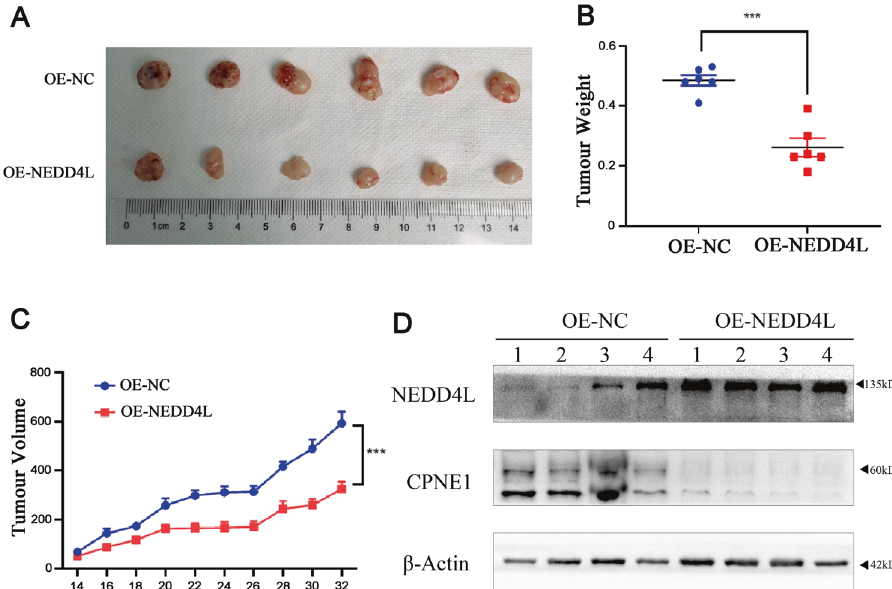
Fig. 7 Suppression of in vivo tumor growth by NEDD4L overexpression. A NEDD4L overexpression in A549 cell xenografts in nude mice ( n = 6) at the experimental endpoint; tumors were dissected and photographed as shown. B Each tumor was weighed. C Tumor growth curves in mice ( n = 6 in each group) inoculated with the indicated cells at the indicated days. D NEDD4L protein expression in tumors was detected by Western blot. *** P < 0.001.